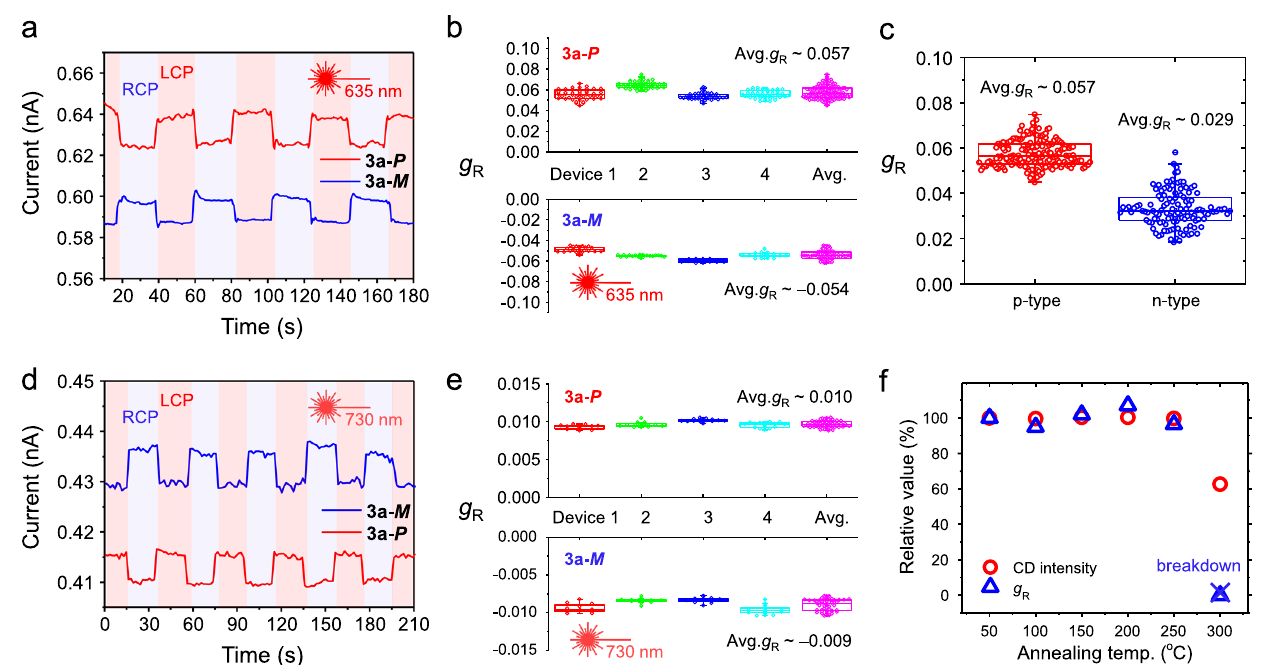
Fig. 6 Selective CPL detection properties. a Real-time current signal of 3a- P / M -based OFETs under CPL irradiations ( λ = 635 nm) in p -type mode (the recorded current was plotted as absolute value). b Quantitative analysis results of g R of four 3a- P / M -based OFET devices under CPL irradiations ( λ = 635 nm) in p -type mode. c Quantitative analysis results of g R of four 3a- P - based OFET devices under CPL irradiations ( λ = 635 nm). d Real-time current signal of 3a- P / M -based OFETs under CPL irradiations ( λ = 730 nm) in p -type mode (the recorded current was plotted as absolute value). e Quantitative analysis results of g R of four 3a- P / M -based OFET devices under CPL irradiations ( λ = 730 nm) in p -type mode. f Relative CD intensity and g R value of 3a- M -based OFETs under CPL irradiations ( λ = 635 nm) in p -type mode after thermal